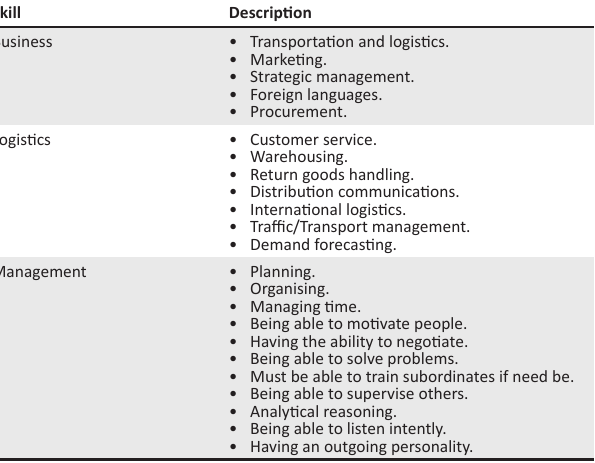
TABLE 1: Business, logistics and management skills expected from supply chain graduates.